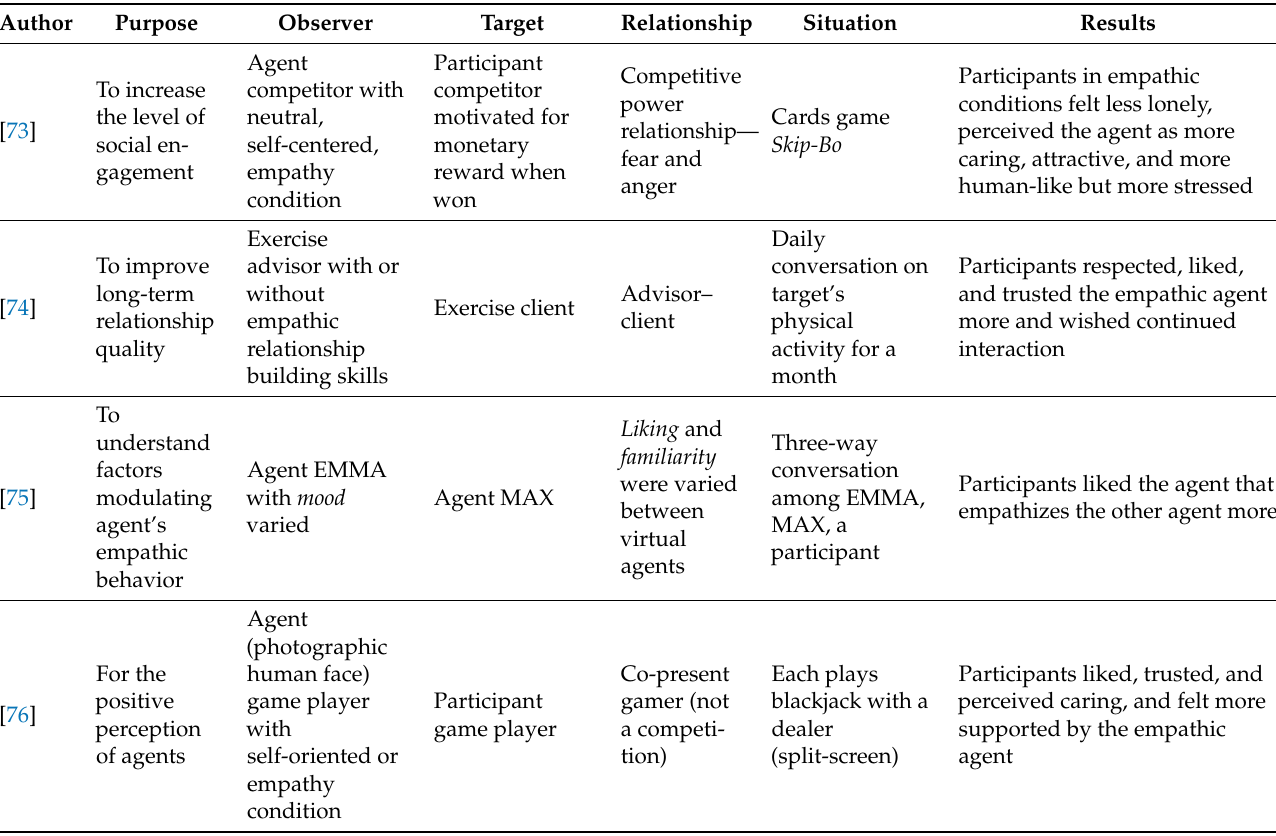
Table 3. Studies on empathic virtual